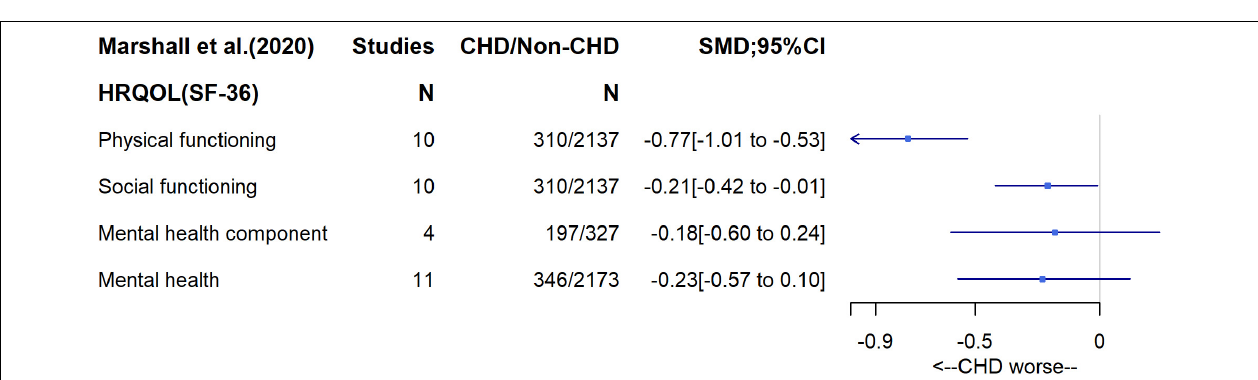
FIGURE 5 | Relative risk of mortality, repeat operation and need for renal dialysis following cardiac transplantation in CHD patients compare with patients receiving transplant for other diseases.